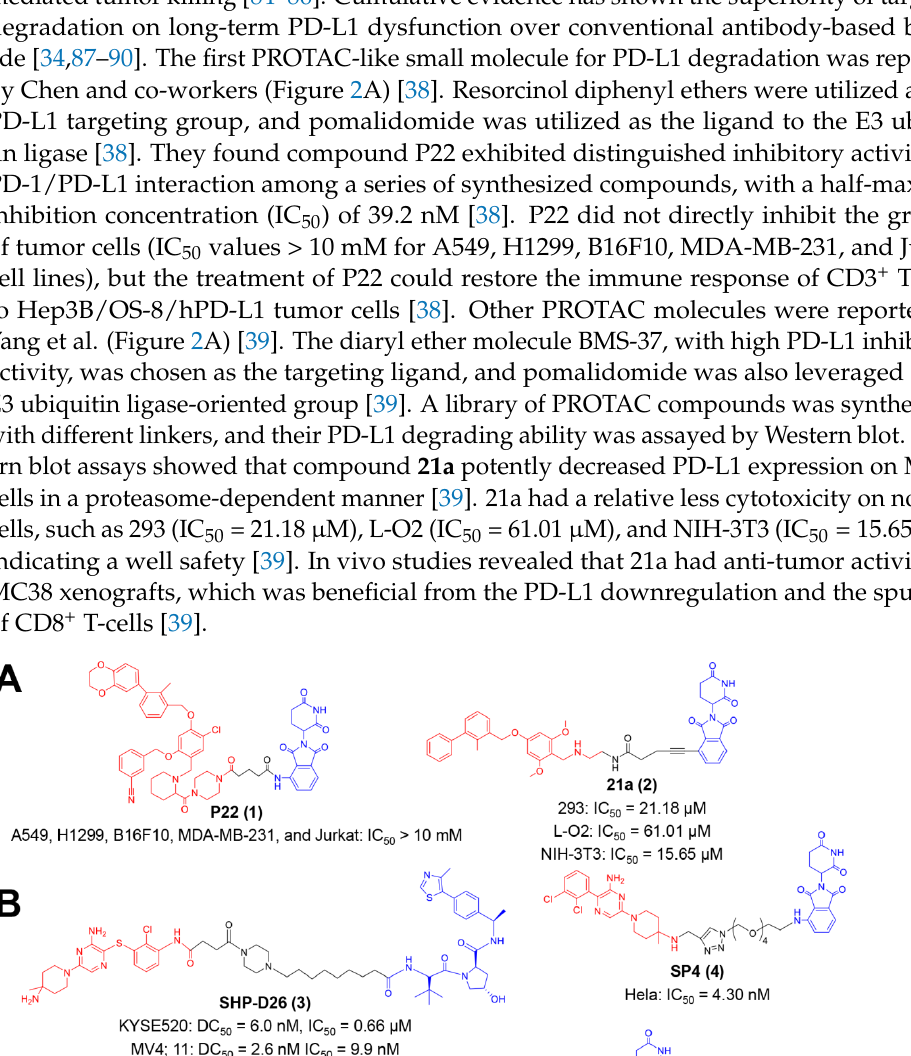
Figure 2. The chemical structures of representative PROTACs targeting the PD-1/PD-L1 checkpoint signal axis. ( A ) The chemical structures of representative PROTACs targeting PD-L1 protein. ( B ) The chemical structures of representative PROTACs targeting SHP-2. ( C ) The chemical structures of representative PROTACs targeting BET. DC 50 — half-maximal degradation concentration; IC 50 — half-maximal inhibition concentration.